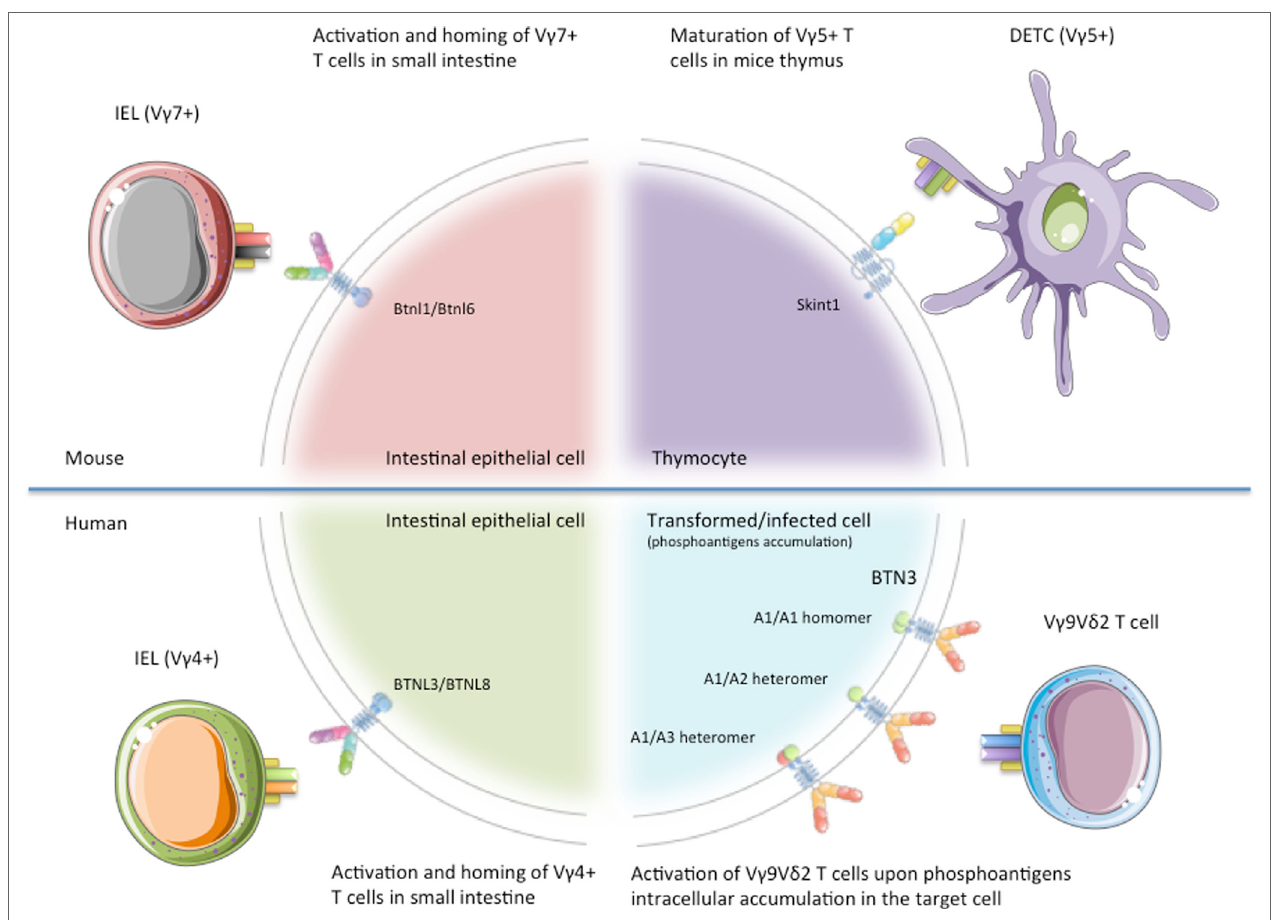
FiGURe 2 | Schematic representation of the different γδ T cell subsets regulated by Btn/Btnl proteins. Representation of the published functions of BTN/BTNL proteins on specific γδ T cell subsets. Skint-1 has been shown as critical for the maturation of V γ 5V δ 1 + dendritic epidermal T cells (DETCs) in mice thymus. Btnl1/ Btnl6 promote V γ 7 + intraepithelial lymphocytes (IELs) maturation and expansion within mice small intestine, whereas BTNL3/BTNL8 regulate the activation of V γ 4 + IEL in human gut epithelium. Finally, BTN3A molecules play a mandatory role in the recognition of tumor or stressed cells by human V γ 9V δ 2 T cells. This figure was created in part using graphics from Servier Medical Art (https://smart.servier.com/) with